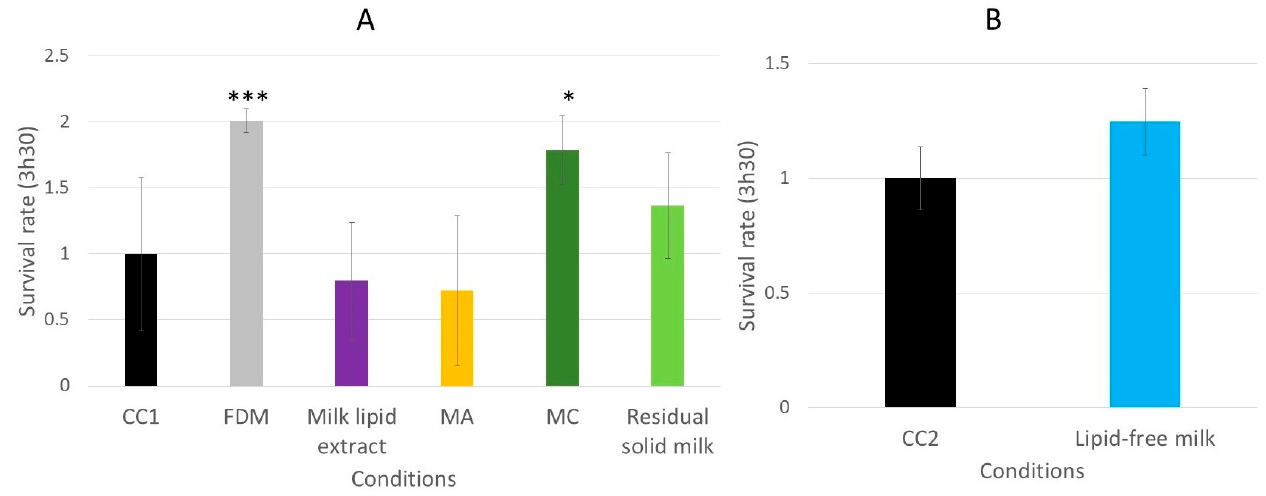
Figure 12. The relative survival rates of the wild-type C. elegans N2 strain on an oxidative medium after 5 days of incubation on a medium supplemented with FDM (freeze-dried milk), milk lipid extract, extract MA (obtained with dichloromethane), MC (obtained with ethanol) and RSM (residual solid milk) ( A ) or LFM (lipid-free milk) ( B ). The conditions were considered significantly different from the control when the p -value was lower than 0.05 (*) or 0.001 (***) (Kruskal–Wallis test).